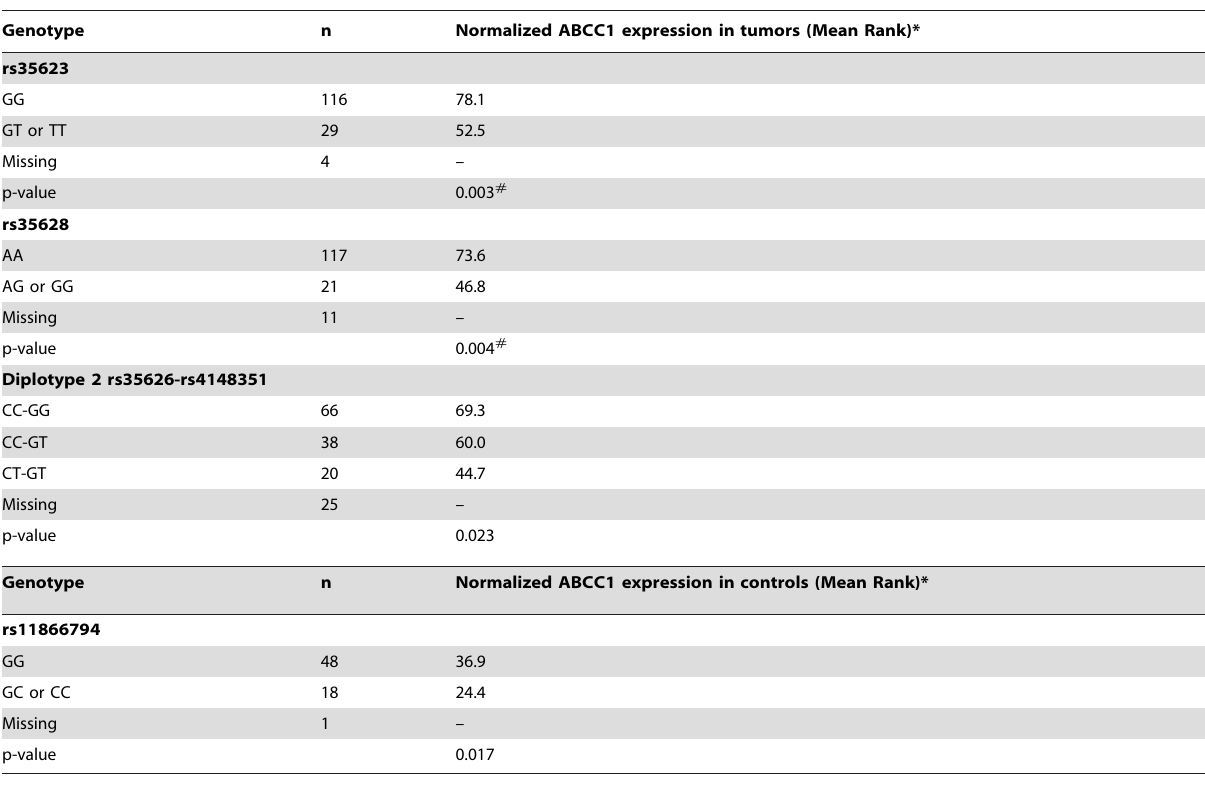
Table 4. Significant associations of ABCC1 polymorphisms with expression